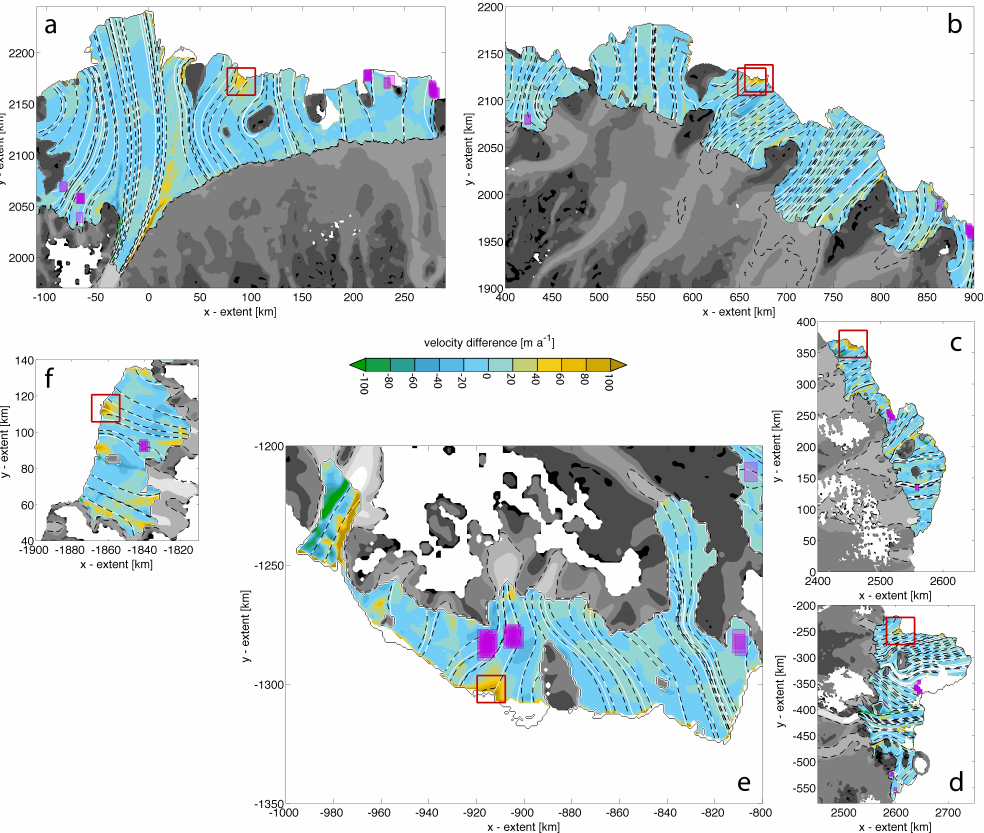
Figure 6. Velocity differences as in Fig. 4 for different ice shelves around Antarctica: Fimbul (a) , Mushketov (b) , West (c) , Shackleton (d) , Nickerson (e) and Venable (f) . Results are based on the T geometry when accounting for complementary information on pinning points (PIN5) in the inversion. Shading, contour lines and markers as in Fig. 3. Dark red squares give the positions of the seven potential pinning points identified in this study (Table